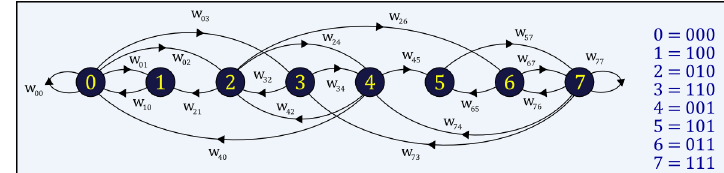
Figure 1. A graph representation of earthquake sequencing with arcs (with weights w ij ) representing transitions between states.